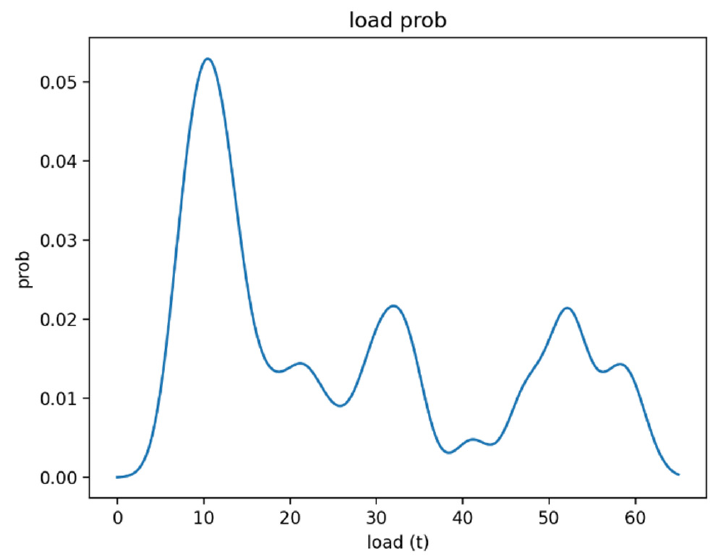
10 of 16 Figure 5. The target mechanism to be monitored. Figure 6. The mounted sensor. Each group of data records a complete working cycle of a crane, including hoisting mechanism lifting, trolley mechanism operation and hoisting mechanism lowering. The specific contents of each group of data include the signals of 16 vibration sensors, the sig- nals of 2 speed sensors and the trolley position, lifting sling position and lifting weight obtained from the PLC (Programmable Logic Controller). These data are stored in csv format, and each group of data may contain multiple work cycles. In the preprocessing stage of the data, it is split into individual work cycles using the spreader unlock signal as a boundary. The sampling frequency of most signals is 1Hz, and the sampling frequency of gearbox vibration signal is 12,800 Hz. 4.2. Load Spectrum and Energy Consumption